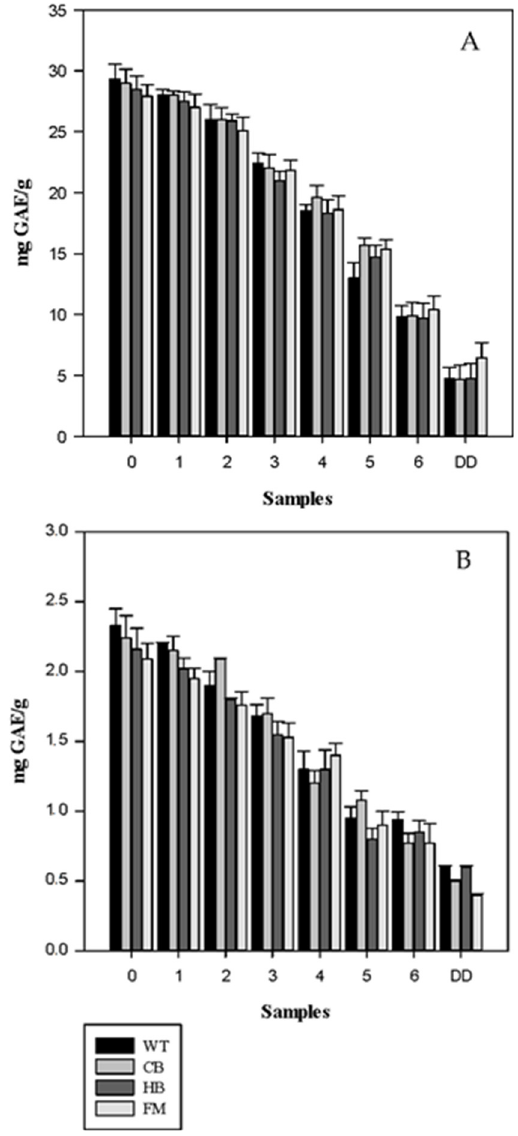
Figure 4. Total phenolic content in natural (NS, panel ( A )) and blanched (BS, panel ( B )) almond skin before and after simulated human digestion. Values are expresses in mg GAE/g and they represent mean ± SD of three different experiments. 0 to 6: gastric samples (see Table 1 for sampling time). DD: sample post in vitro gastric + duodenal digestion. Water (WT), home-made biscuits (HB), crisp-bread (CB) and full-fat milk (FM).